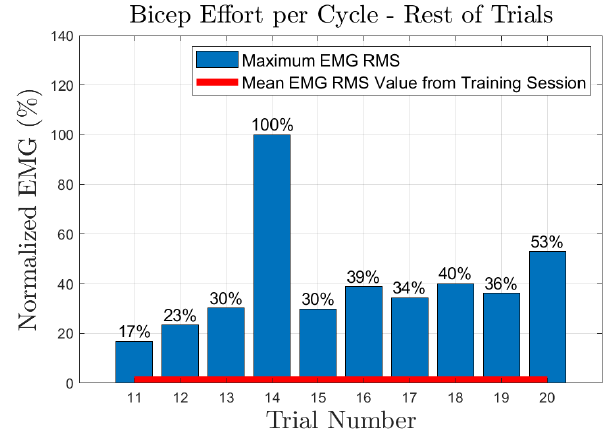
Figure 21. Subject 2: Flexion sEMG RMS values per trial.